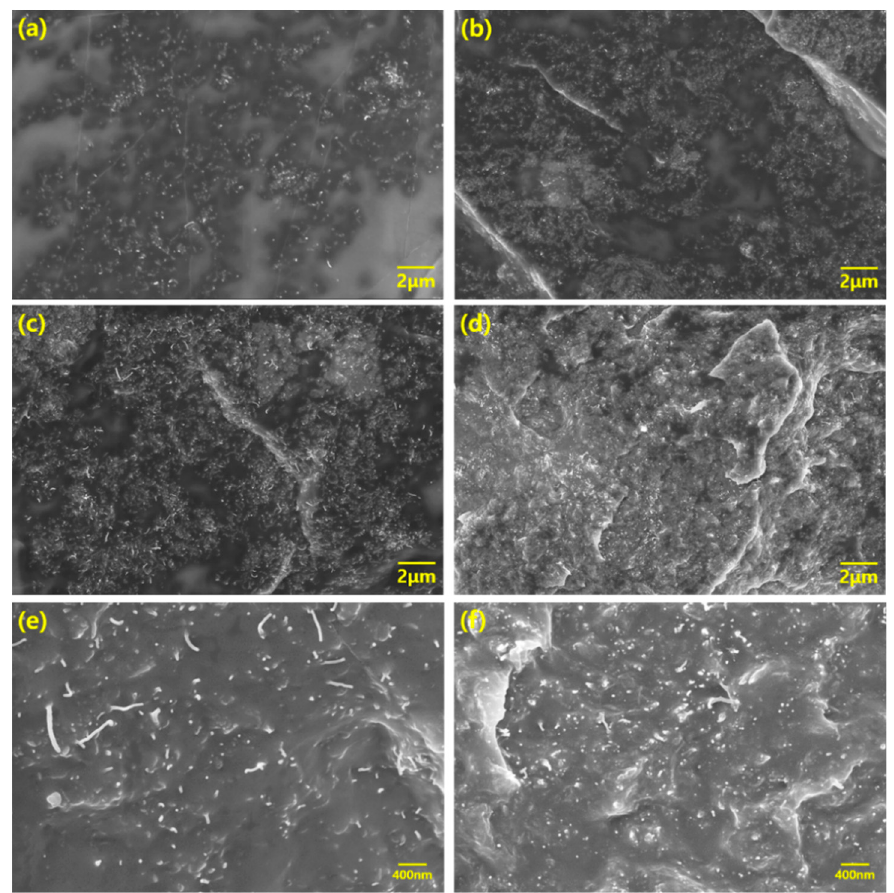
Figure 3. SEM images of MWCNT/PDMS composites: ( a ) 1 wt% LCNT/PDMS, ( b ) 1 wt% HCNT/PDMS, ( c ) 5 wt% LCNT/PDMS, ( d ) 5 wt% HCNT/PDMS with low resolution, and ( e ) 5 wt% LCNT/PDMS, ( f ) 5 wt% HCNT/PDMS with high resolution.